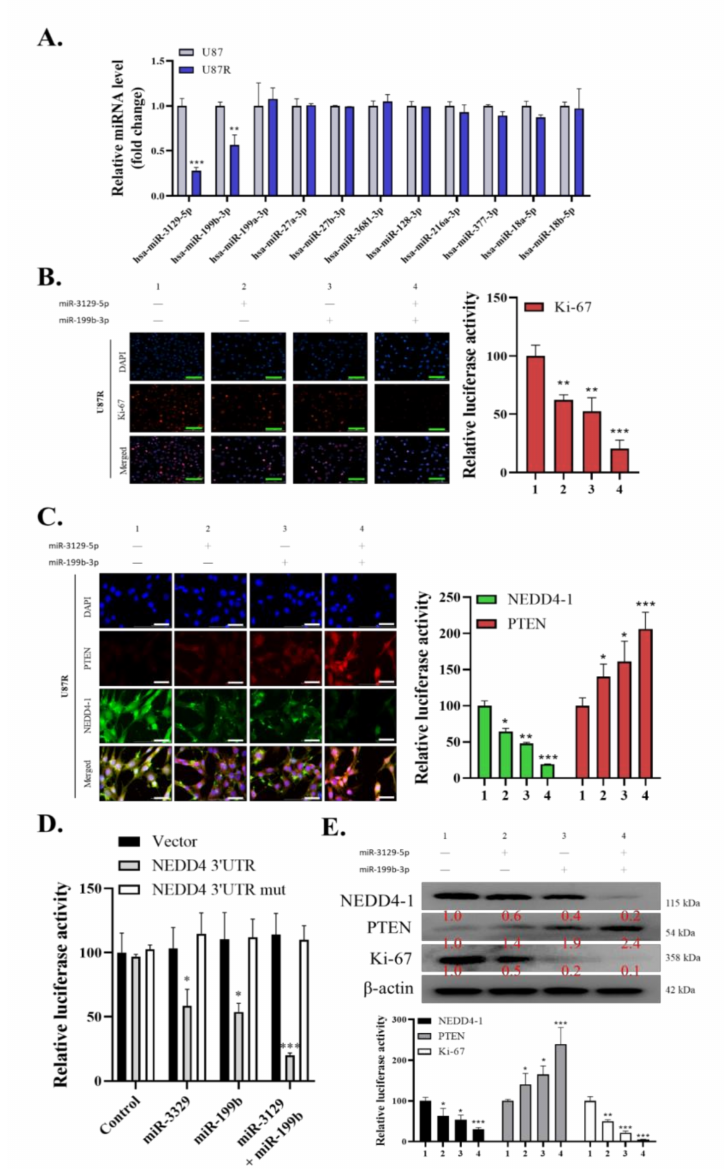
Figure 3. miR-3129-5p and miR-199b-3p regulate NEDD4-1 expression in GBM cell line. ( A ) The top 10 miRNAs with strongest correlation to NEDD4-1 according to the Targetscan database were evaluated for their expression level in U87MG and U87MG R cell lines to find the two most downreg- ulated miRNAs. ( B ) Evaluation of Ki-67 immunofluorescence staining intensity of U87MG R cell line transfected with miR-3129-5p and miR-199b-3p mimics. DAPI staining (blue) was used to label DNA in all cells. Scale bar = 100 µ m ( C ) Immunofluorescence staining of NEDD4-1 and PTEN in U87MGR cell line transfected with miR-3129-5p and miR-199b-3p mimics demonstrating differential localization. DAPI staining (blue) was used to label DNA in all cells. Scale bar = 100 µ m. ( D ) U87MGR cells were co-transfected with miR-3129-5p, miR-199b-3p, or a control mimic (miR-NC), as well as a wild-type or mutated (mut) NEDD4-1 3 (cid:48) UTR-directed luciferase reporter. Luciferase activity was measured by dual-luciferase reporter assays. ( E ) Western blot analysis of NEDD4-1 and PTEN differential protein expression in U87MGR cells transfected with control mimic (miR-NC), miR-3129-5p, miR-199b-3p, or both. Graph bars are the mean ± SEM of three independent experiments. * p < 0.05, ** p < 0.01, *** p <